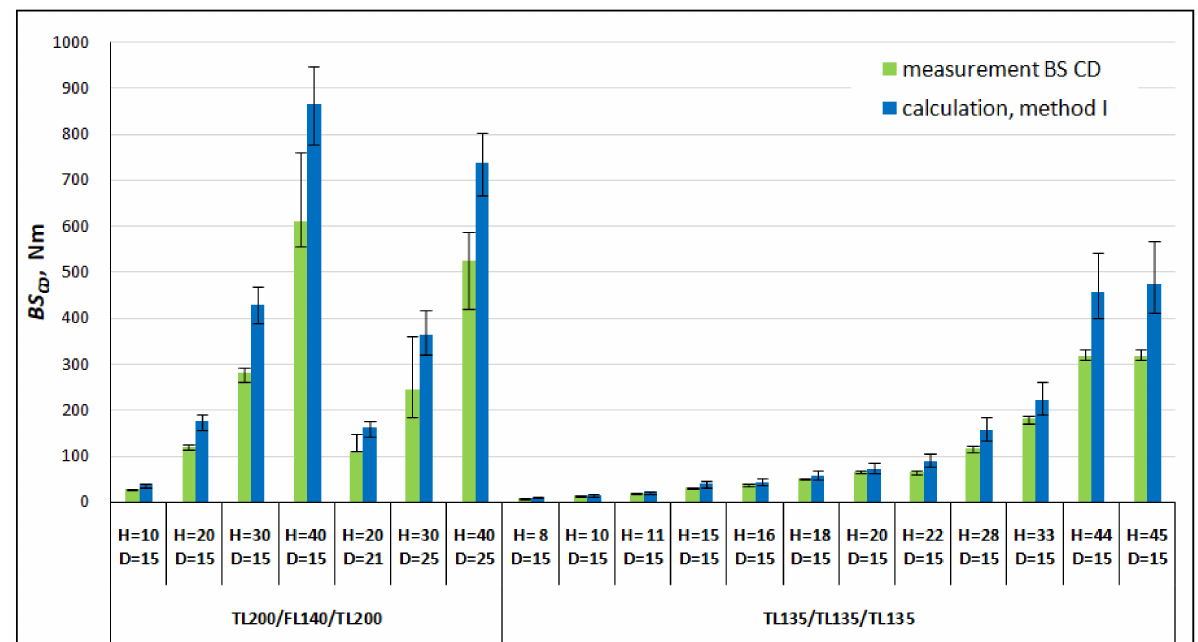
Figure 9. Comparison of the results and calculations of bending stiffness in the cross direction ( CD ).